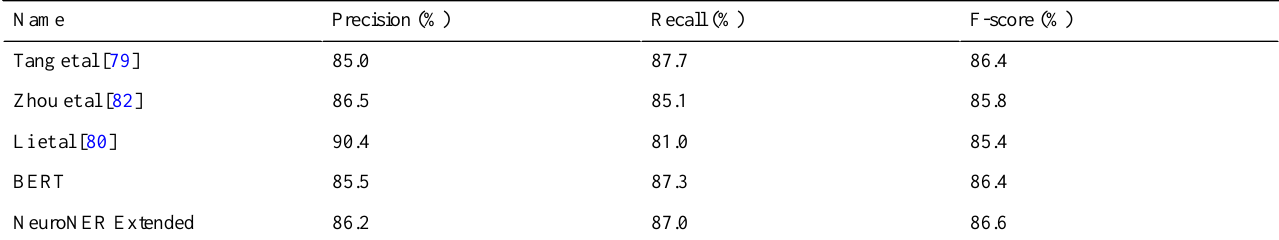
Table 18. Task 1W biological sentence-level speculation detection (BioScope).